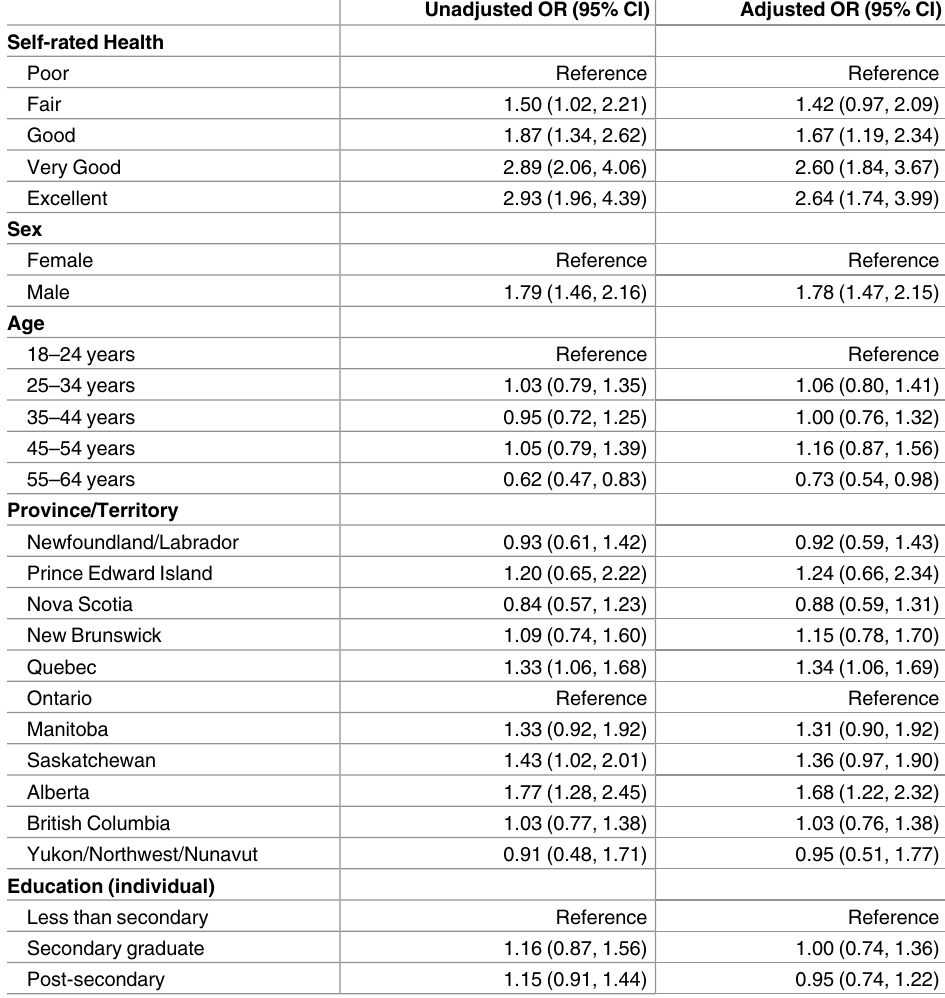
Table 3. Logistic regression analysesof the relationship between self-rated health and the reasons for non-vaccination ( Unnecessary –Yes vs . No), against seasonal influenza among Canadian adults with asthma, Canadian Community Health Survey pooled cycles 3.1(2005),2007/08, 2009/10,